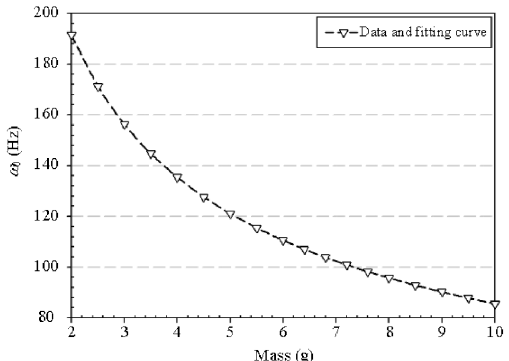
Fig. 2 Relation curve of the sensor natural frequency with the changes in vibrator